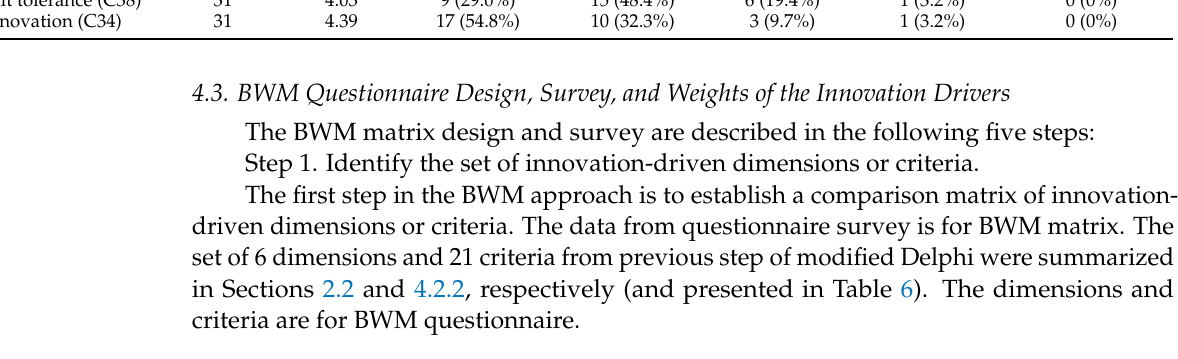
Table 6. BWM set of Dimension/criteria.